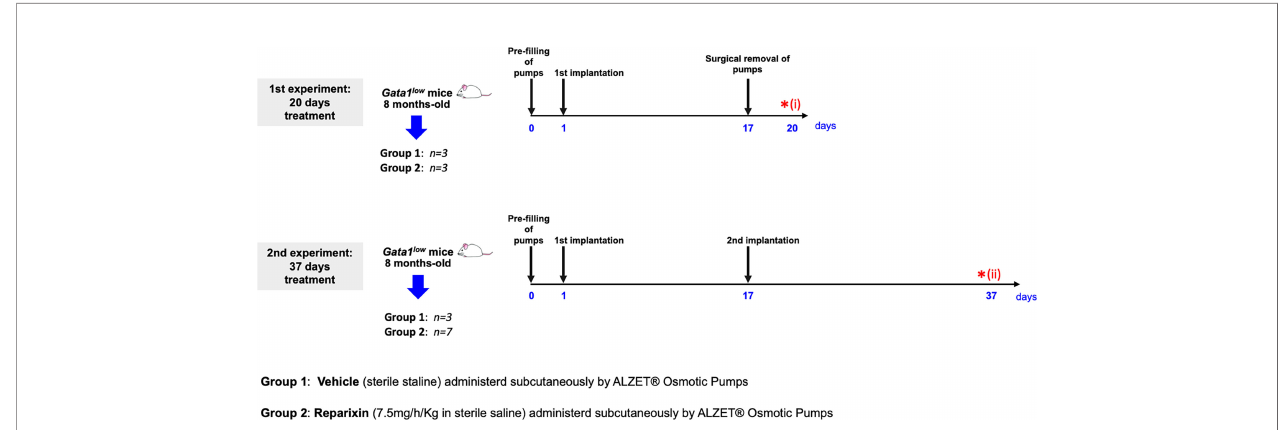
FIGURE 1 | Scheme of the two treatments of Gata1 low mice with either vehicle or Reparixin for 20 (experiment 1) or 37 (experiment 2) days. In experiment 1, mini- pumps were removed at day 17 and three mice per experimental group were sacri fi ced at day 17 for end-point determination. In experiment 2, mini-pumps were removed at day 17 from three vehicles and six Reparixin-treated mice and the mini-pumps were replaced with a second implant. These mice were then treated for 17 additional days and sacri fi ced at day 37. Red asterisks indicate the timing of the sacri fi ce in the fi rst (i) and second (ii)